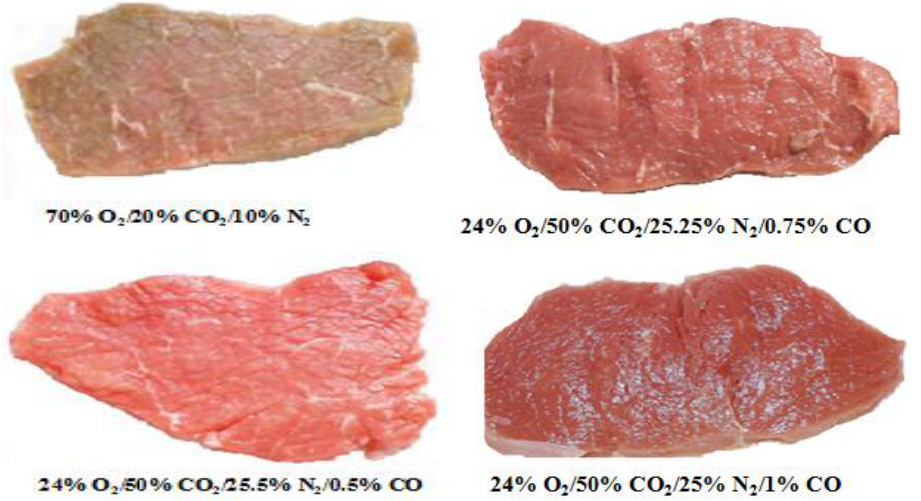
Figure 3. Photos of beefsteaks corresponding to the 21 days of storage under modified atmospheres packaging (MAP) at 1 ± 1 °C [188].